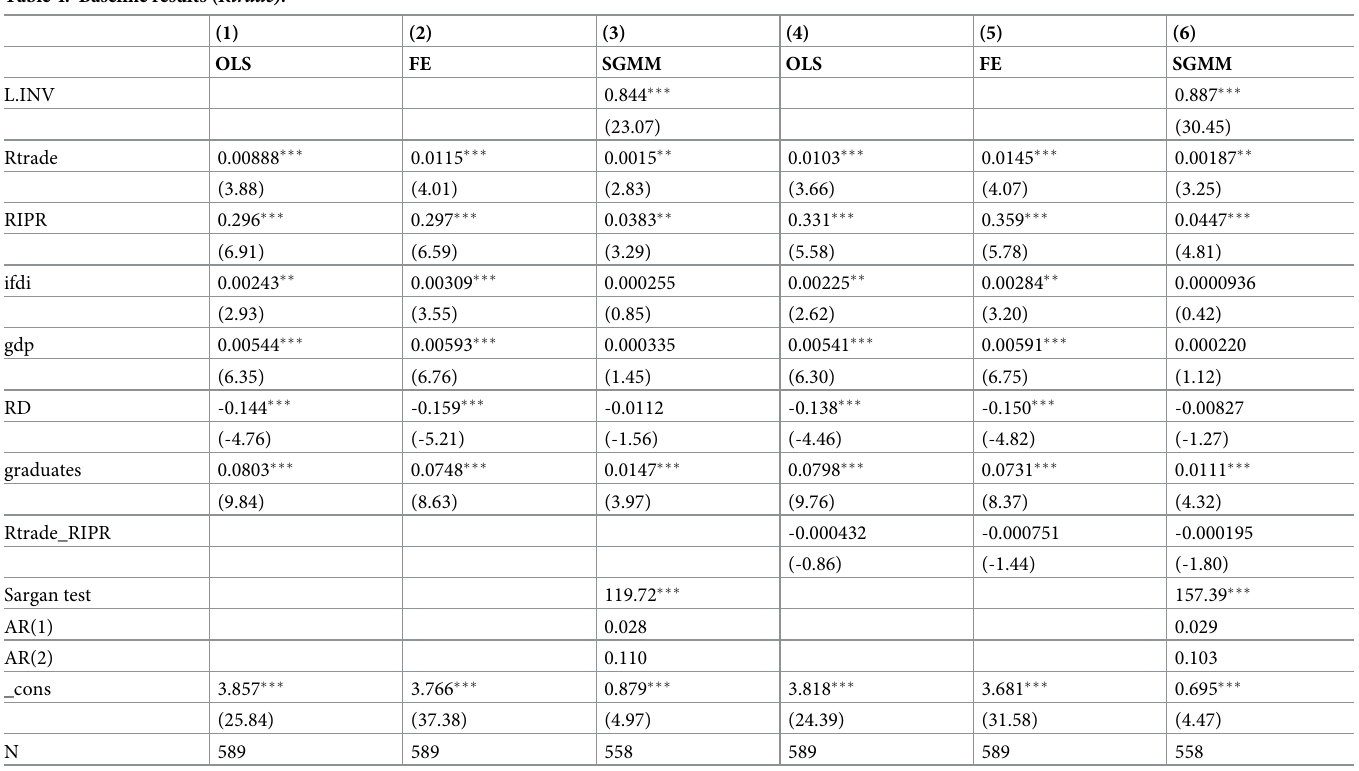
Table 4. Baseline results ( Rtrade) .